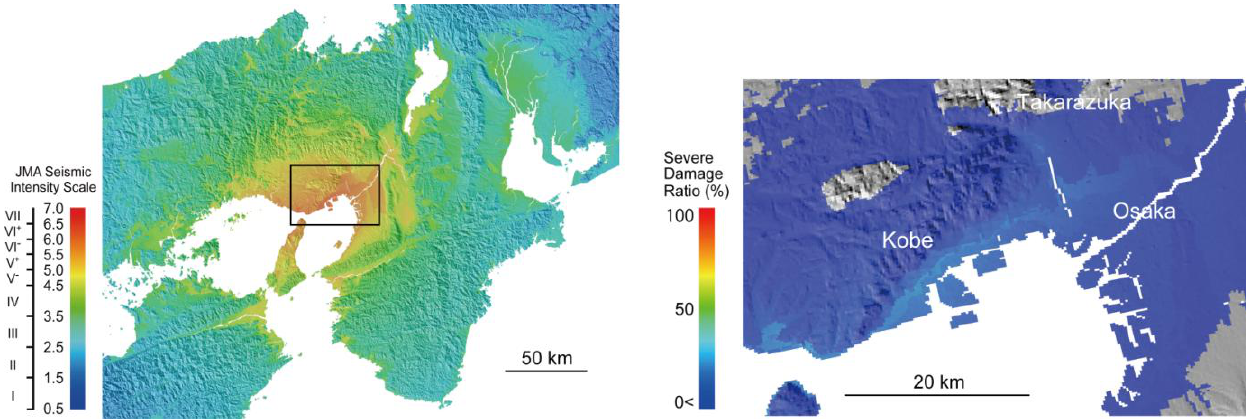
Figure 10. Distribution of estimated seismic intensities (left) and distribution of estimated severe damage ratios from seismic intensity information (average values) (right) for the Kobe